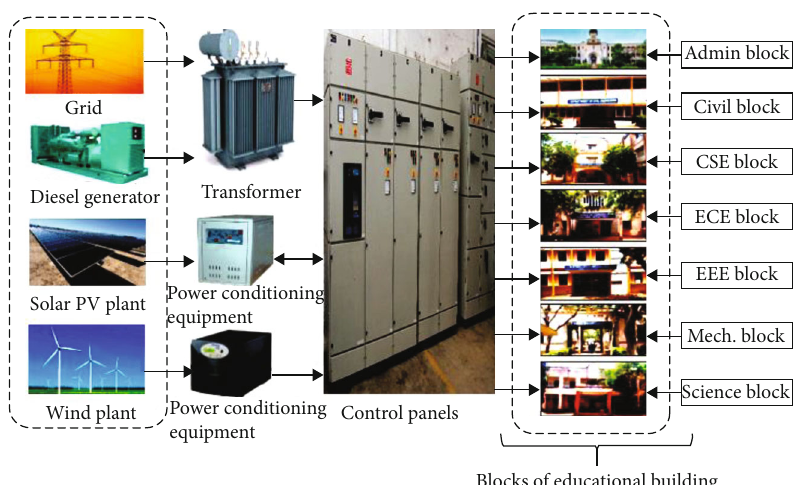
Figure 1: Schematic diagram of the energy distribution network on campus.